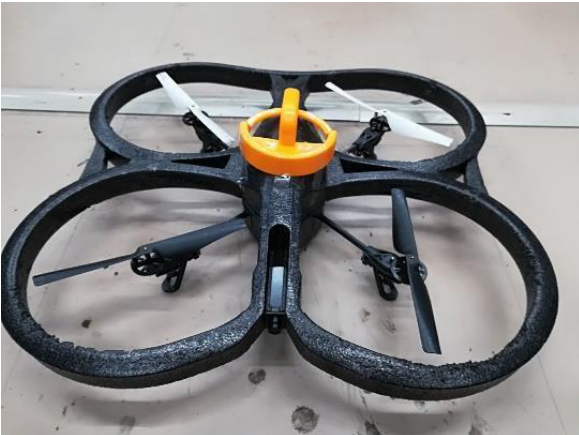
Figure 4 Safe to touch AR drone 2.0